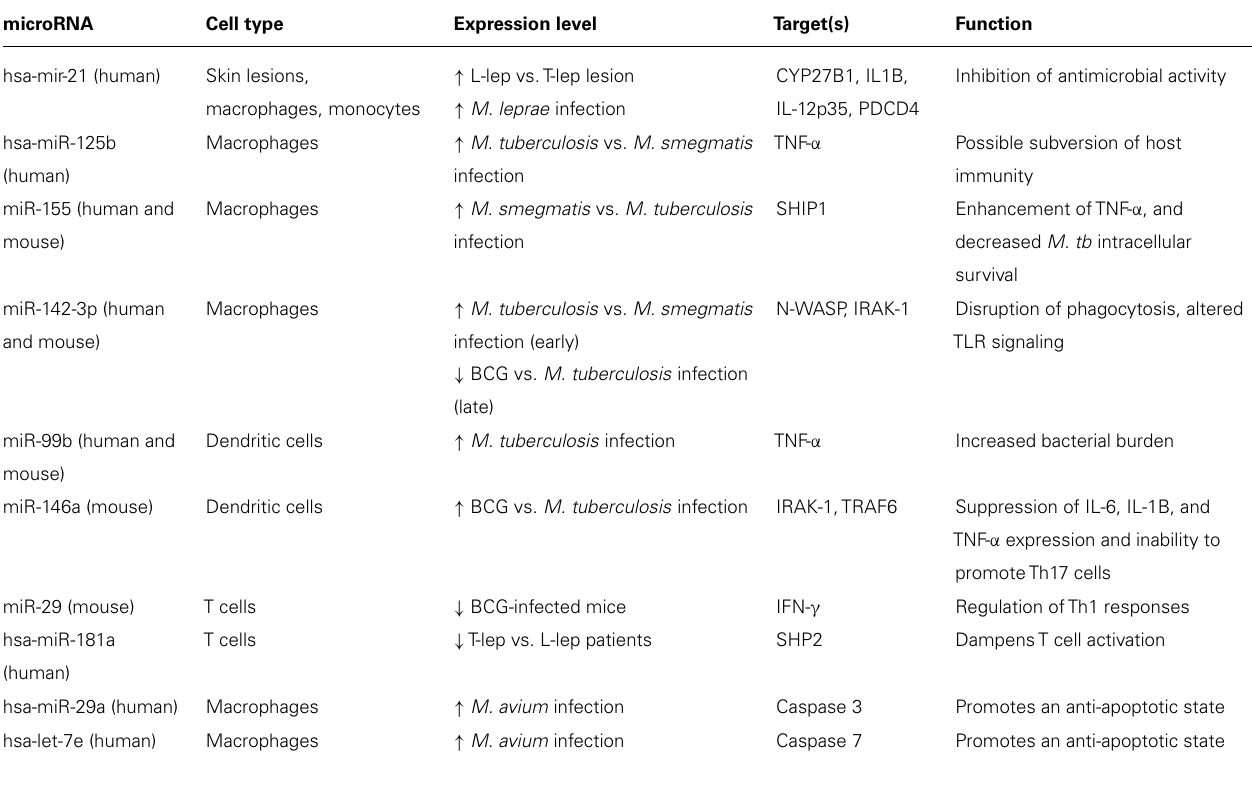
Table 1 | Summary of microRNAs and their impact during